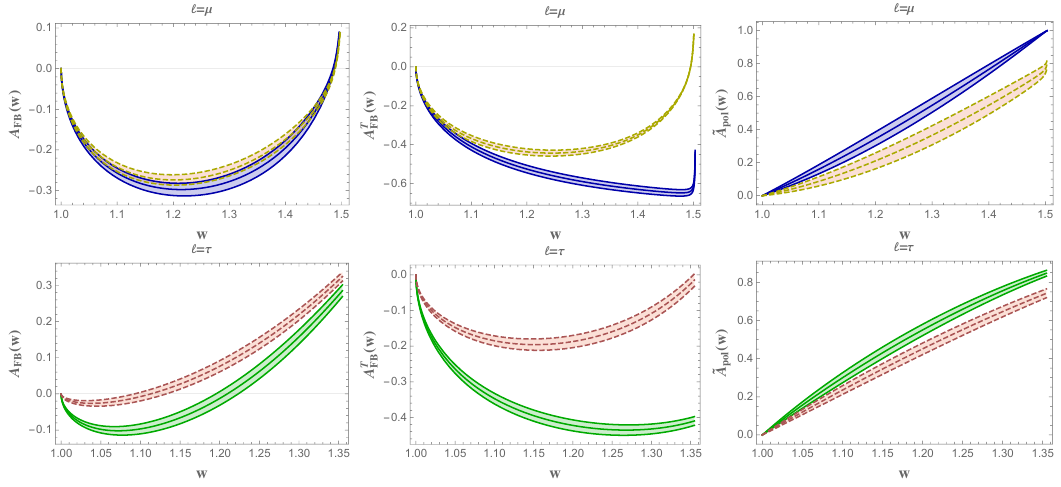
Figure 10 . Observables de(cid:12)ned in eq. (6.1) (left column), (6.4) (middle) and (6.6) (right). The upper and lower plots refer to ‘ = (cid:22) and ‘ = (cid:28) , respectively. The solid curves correspond to SM, the dashed ones to NP at the benchmark point ~ (cid:15) ‘ T